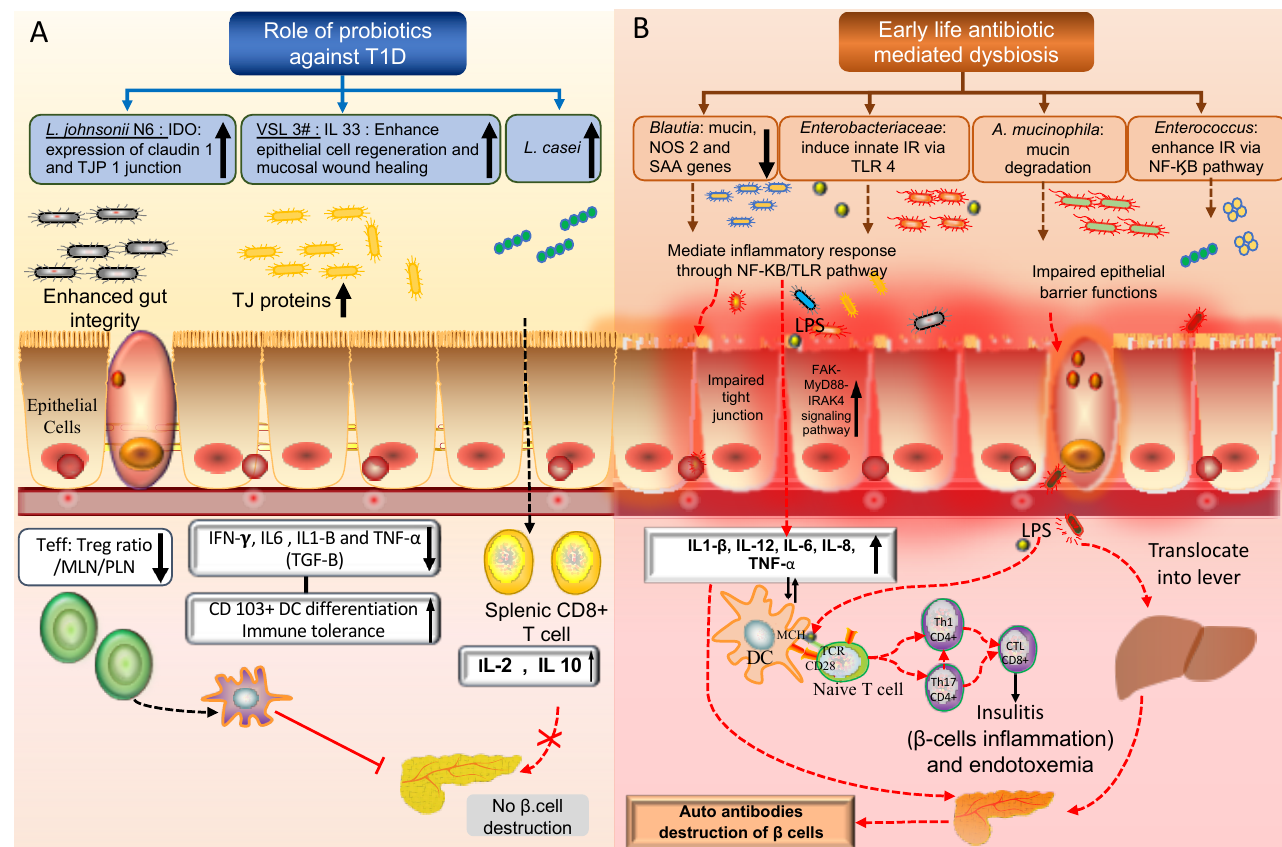
Figure 2 Figure 2. Comparison between the opposite effects of probiotics and early-life use of antibiotics in NOD mice. ( A ) T1D protective effects of probiotic bacteria in NOD mice: Lactobacillus johnsonii N6 enhances the expression of INF γ and indolesamine 2,3-dioxygenase enzyme (IDO) which in turn increase the production of claudin-1 tight junction protein that maintains the integrity of the gut epithelium. Lactobacillus casei has probiotic properties, lowering the number of the splenic CD8 + cytotoxic T cells and promoting the expression of the anti-inflammatory cytokines (IL2, IL10) leading to increased immune tolerance in the gut. VSL3# probiotic has immune-modulatory functions, enhancing the expression of IL-33 cytokine that is necessary to maintain immune-tolerance in the gut and mesenchymal lymph nodes (MLN). ( B ) Role of antibiotic mediated dysbiosis in enhancing autoimmunity and pancreatic β -cells destruction in NOD mice: dysbiosis mediated by the use of antibiotics enhances the growth of pathogenic bacteria which promotes the inflammatory response via the TLR pathway which influences the gut permeability leading to metabolic endotoxemia. Endotoxemia stimulates the autoreactive T cells in the pancreatic lymph nodes leading to insulitis and β cell destruction. The figure was created using BioRender.com and Science slides